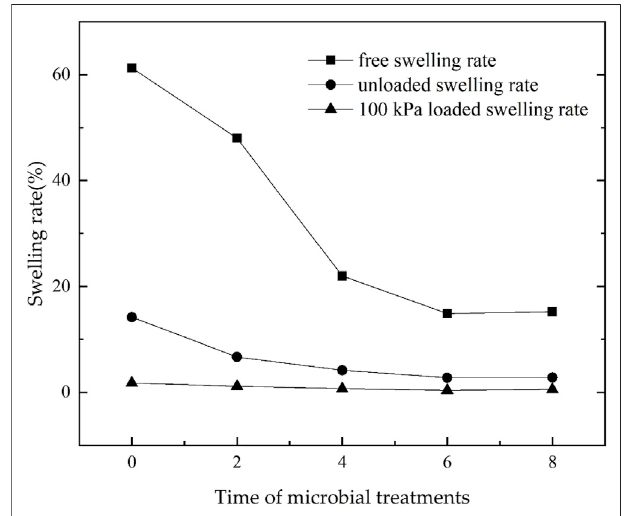
FIGURE 2 | Tested results of swelling ratios of improved soil samples.